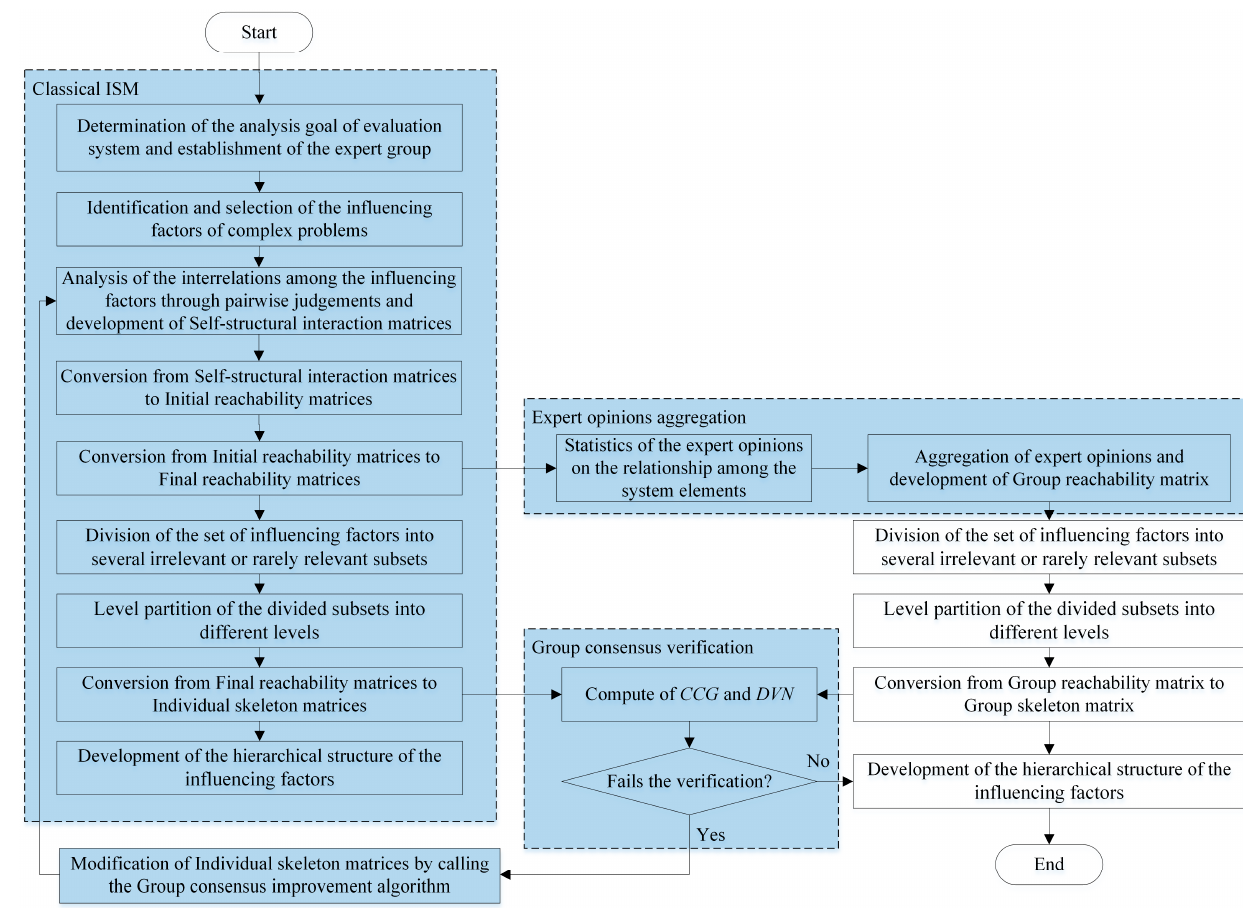
Figure 2. Flow chart of the improved ISM technique.